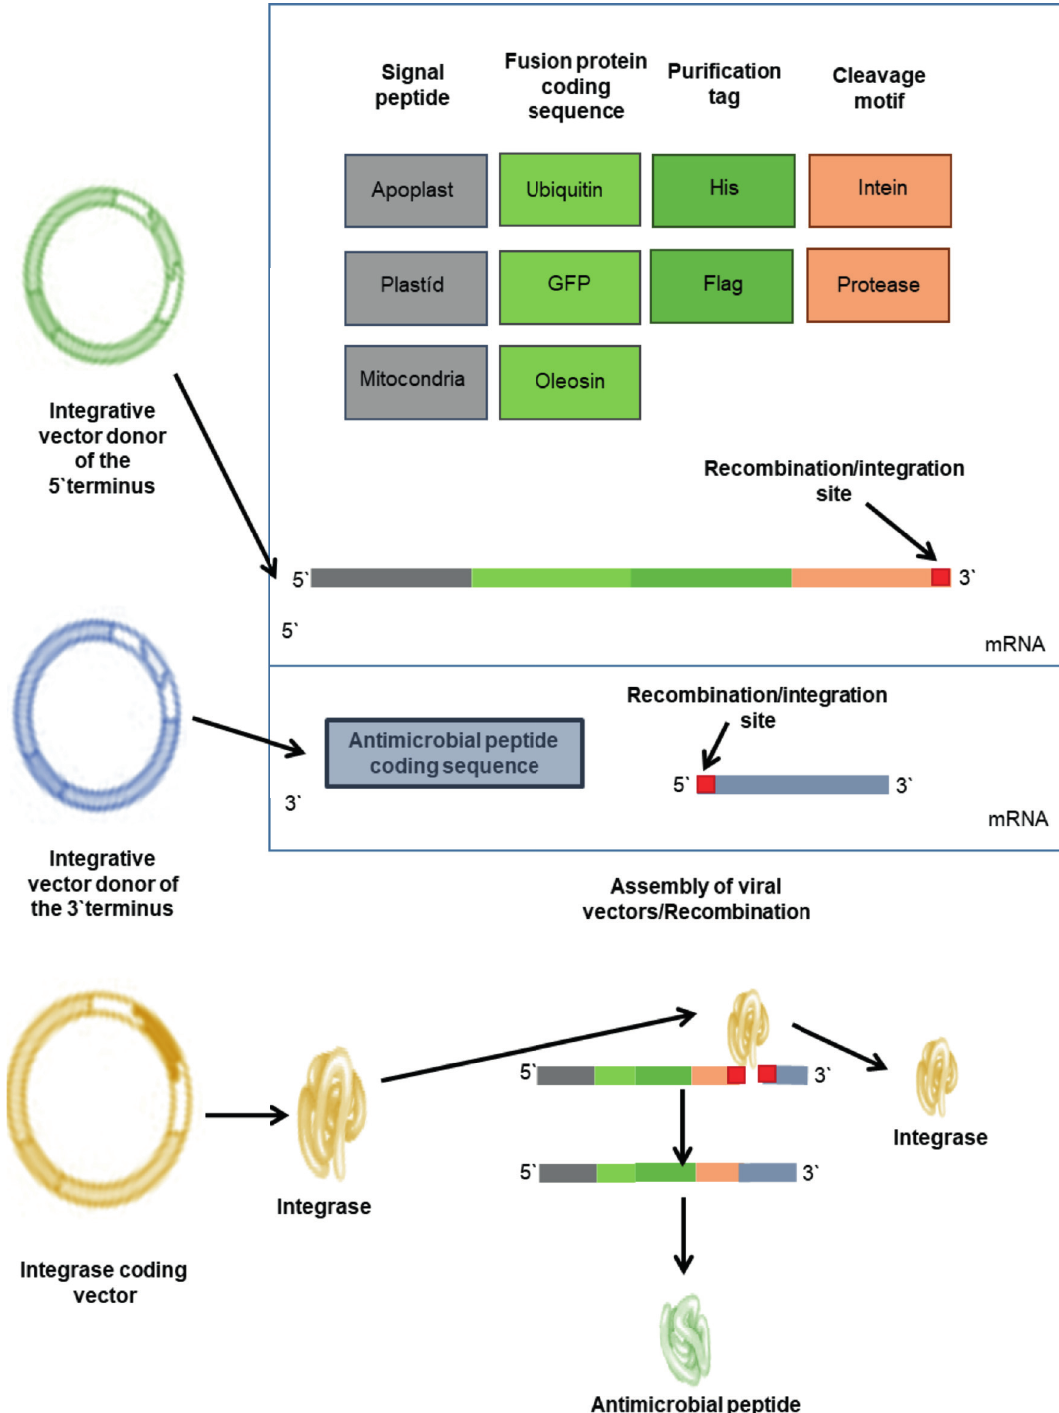
Figure 3 - Pro-vector system for assembly of gene expression modules. Two viral vectors, donors respectively of the 5 ‘and 3’ ends, are specifi cally recognized by the enzyme Integrase C31 from Streptomyces sp. The enzyme catalyzes the recombination between the fragments by the pairing of homologous bases at the recombination sites. The fi nal hybrid fragment presents all genetic elements for large-scale gene expression and for the addressing / purifi cation of recombinant